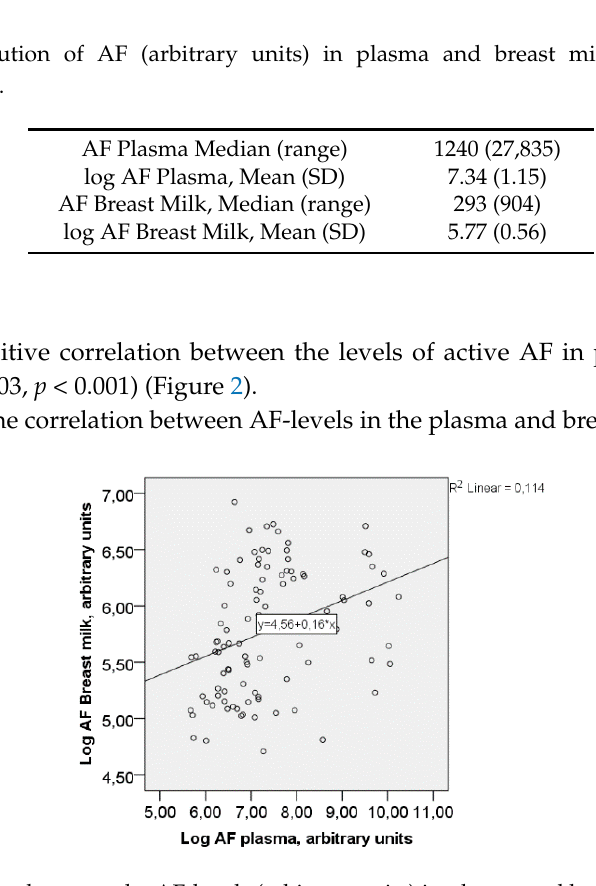
Figure 2. Correlation between the AF-levels (arbitrary units) in plasma and breast milk, Spearman’s rho = 0.403, p < 0.001.